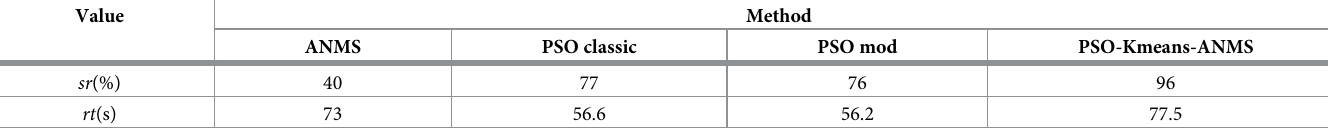
Table 13. Case 3 (100 × 10). Results of the success rate ( sr ) and the average execution time ( rt ) for each optimization algorithm.